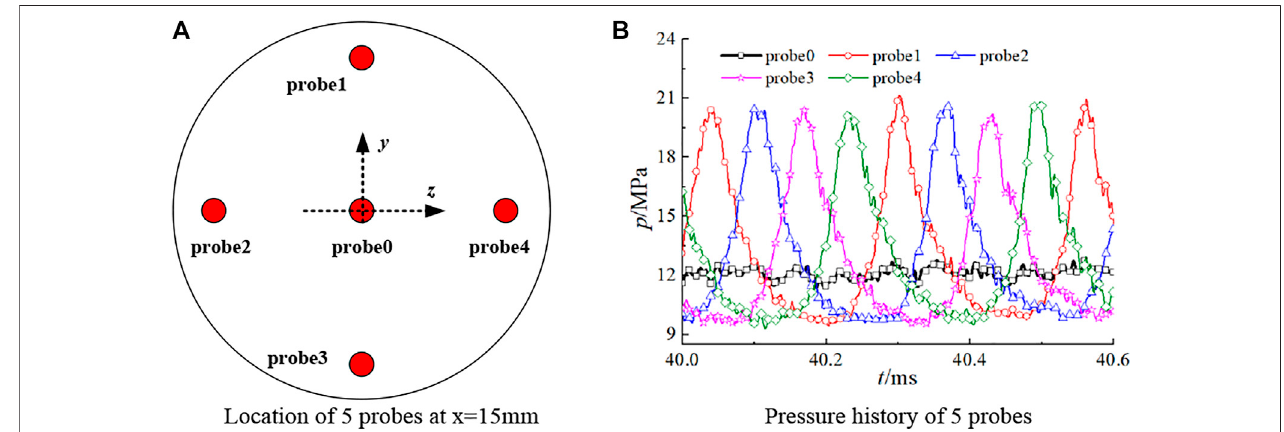
FIGURE12 | Pressure and heat-release changing process within one cycle incase3. (A) Pressure contours within onecycle. (B) Heat-release contours within one cycle. (C) Relationship between pressure and heat-release in case3.